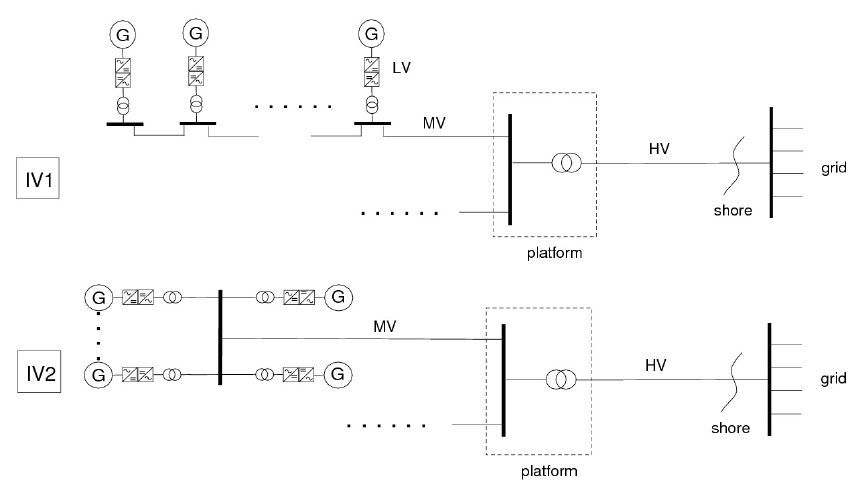
Figure 4 . Individual variable speed with back-to-back